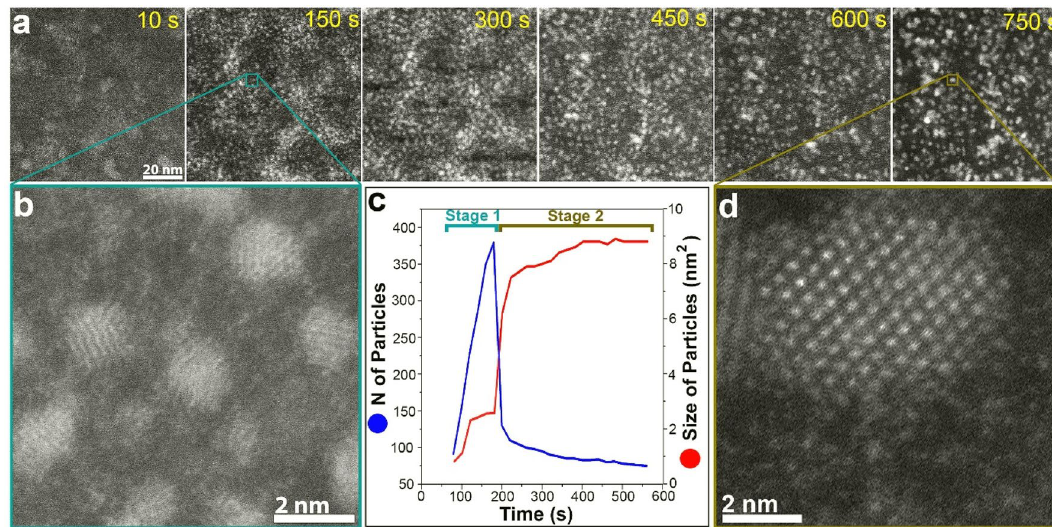
Figure 1. The growth of Pt nanoparticles in a GLC during exposure to the electron beam. ( a ) Sequential ADF-STEM images showing the real-time growth of Pt nanoparticles via two stages. ( b ) High-resolution ADF- STEM image of nanoparticles formed during the first stage (nucleation and monomer attachment). ( c ) Average particles size evolution (red) and the number of particles (blue) as a function of time. ( d ) High-resolution ADF- STEM image of a particle formed during the second stage (nanoparticle attachment). Images are shown in false colour.